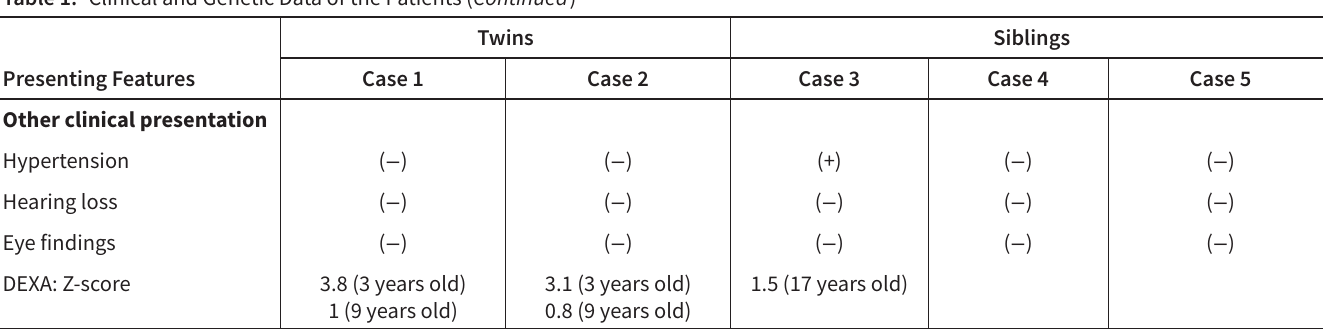
Table 1. Clinical and Genetic Data of the Patients ( Continued )